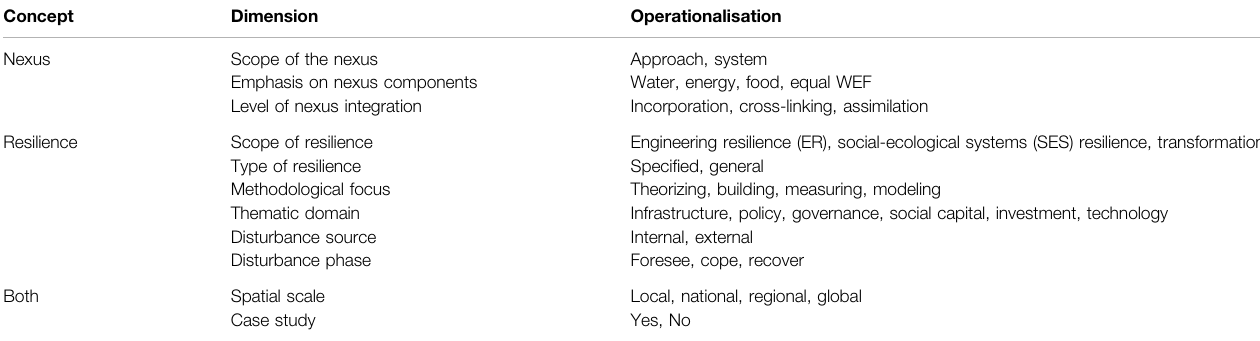
TABLE 1 | Characteristics of the WEF nexus and resilience literature, which are used to map the research